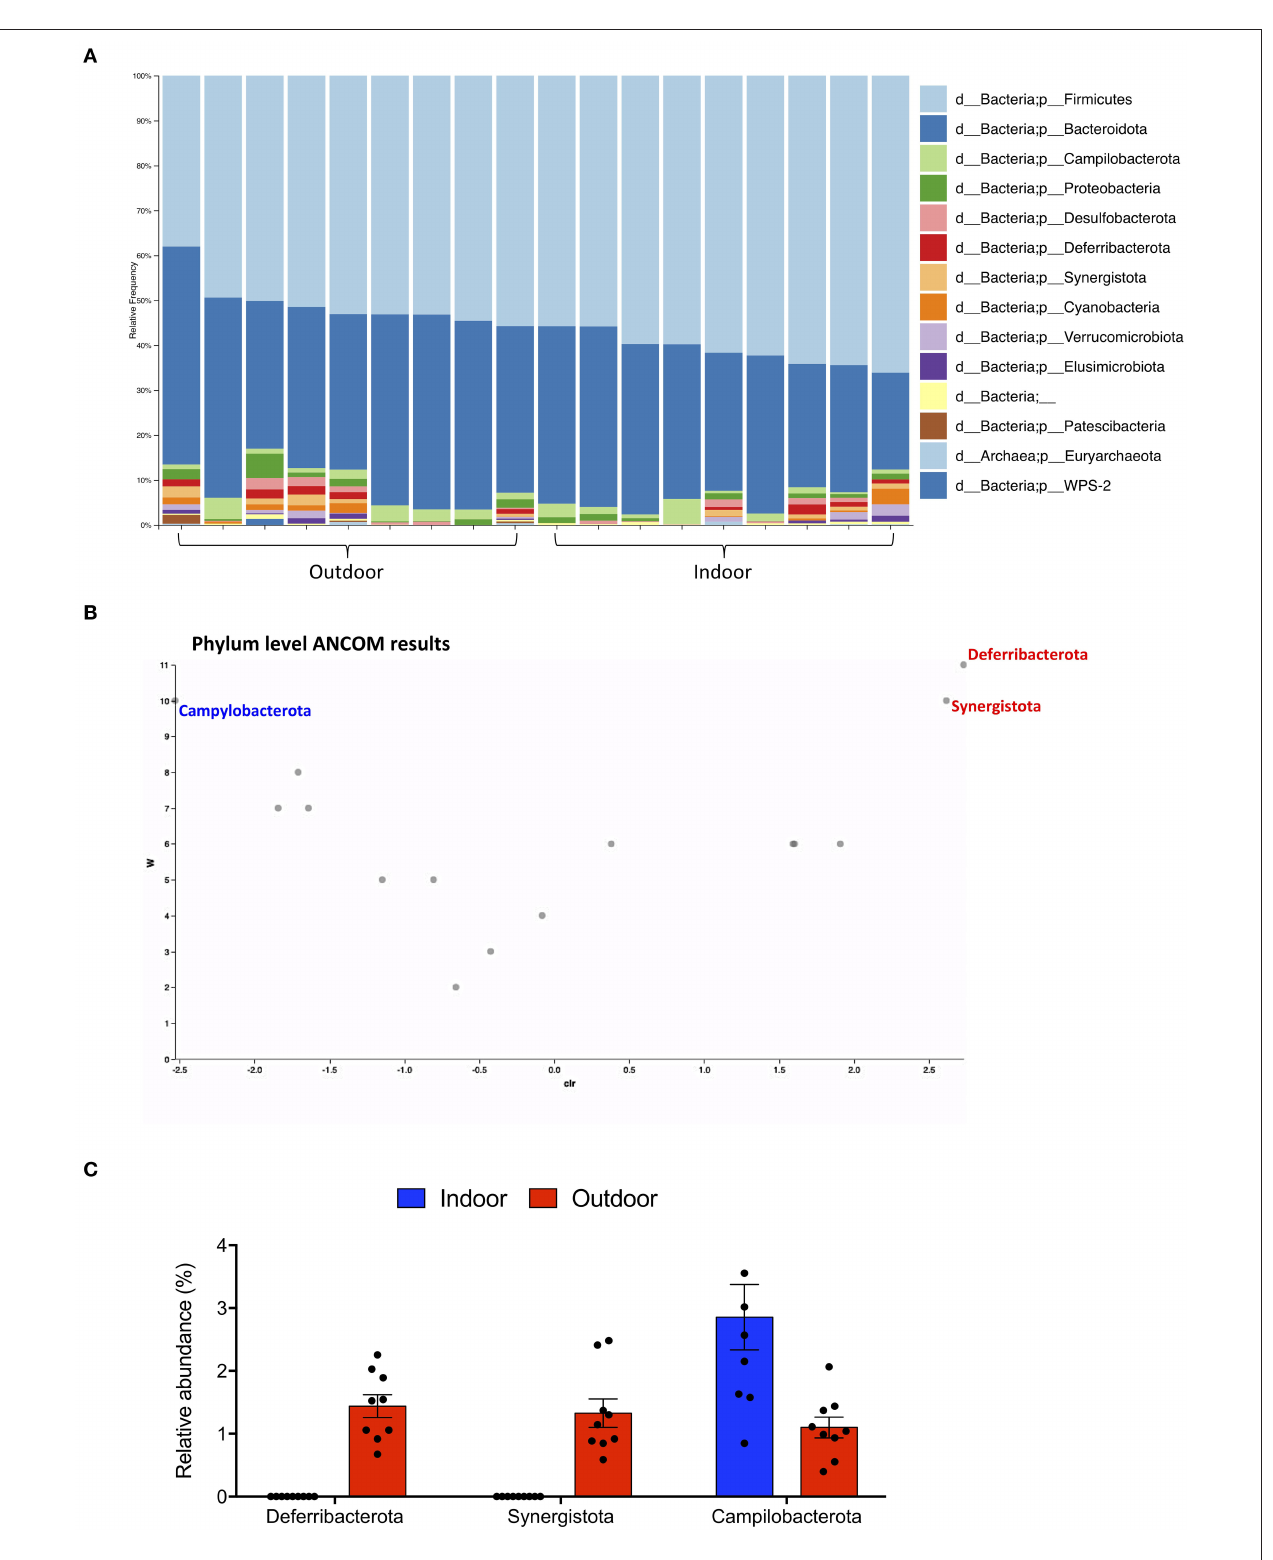
FIGURE 2 | Phylum-level cecal microbiota assortment. (A) Bar chart showing the relative abundance of all bacterial ASVs taxonomically classified at phylum level in each sample. (B) ANCOM differential abundance volcano plot at the phylum level. Only significant bacterial phyla showing high w-stats are labeled and colored in blue or red for Indoor and Outdoor groups, respectively. (C) Bar-dot plot comparing the relative abundance of the phyla whose abundance was found to differ significantly between groups (mean ± SEM).